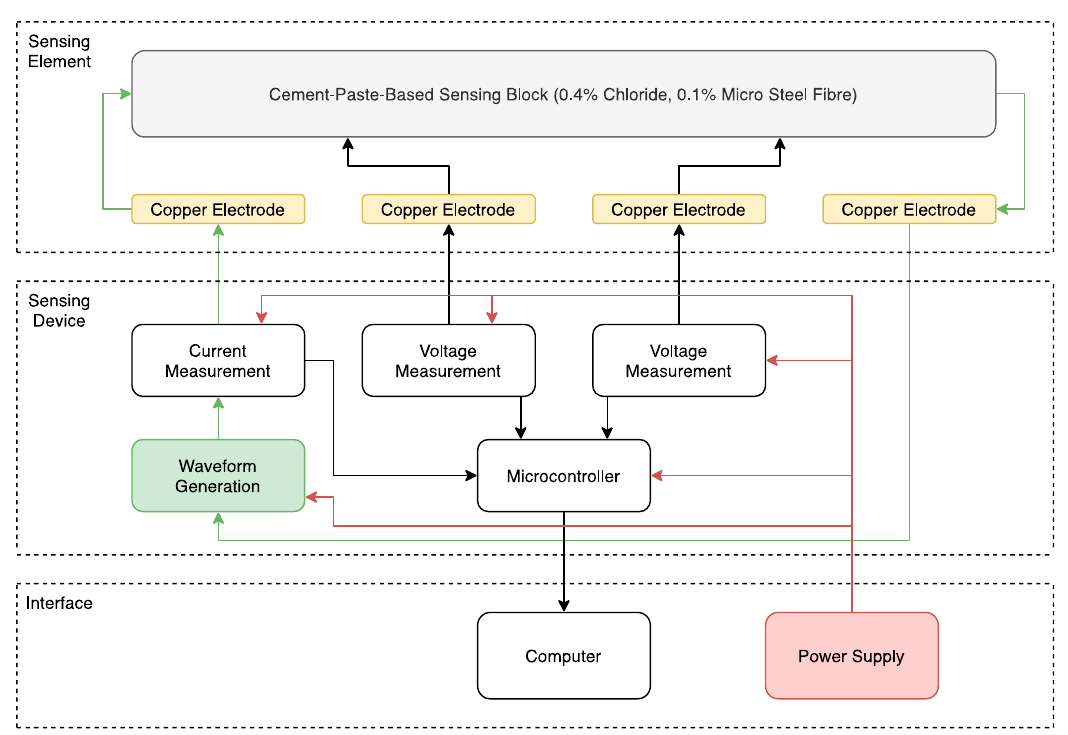
Figure 1. Internal components and system architecture of the concrete resistance measurement device.